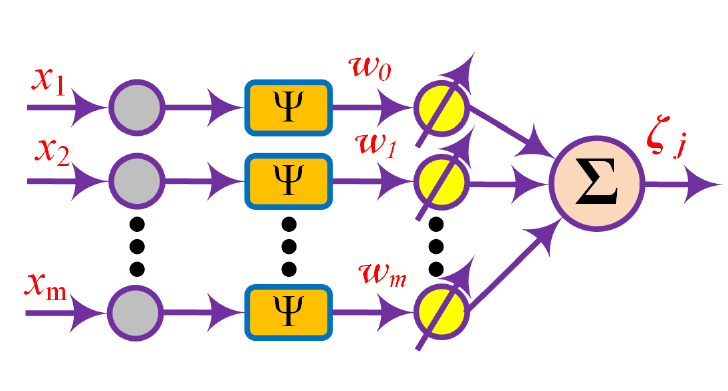
Figure 5. Wavelet Neural